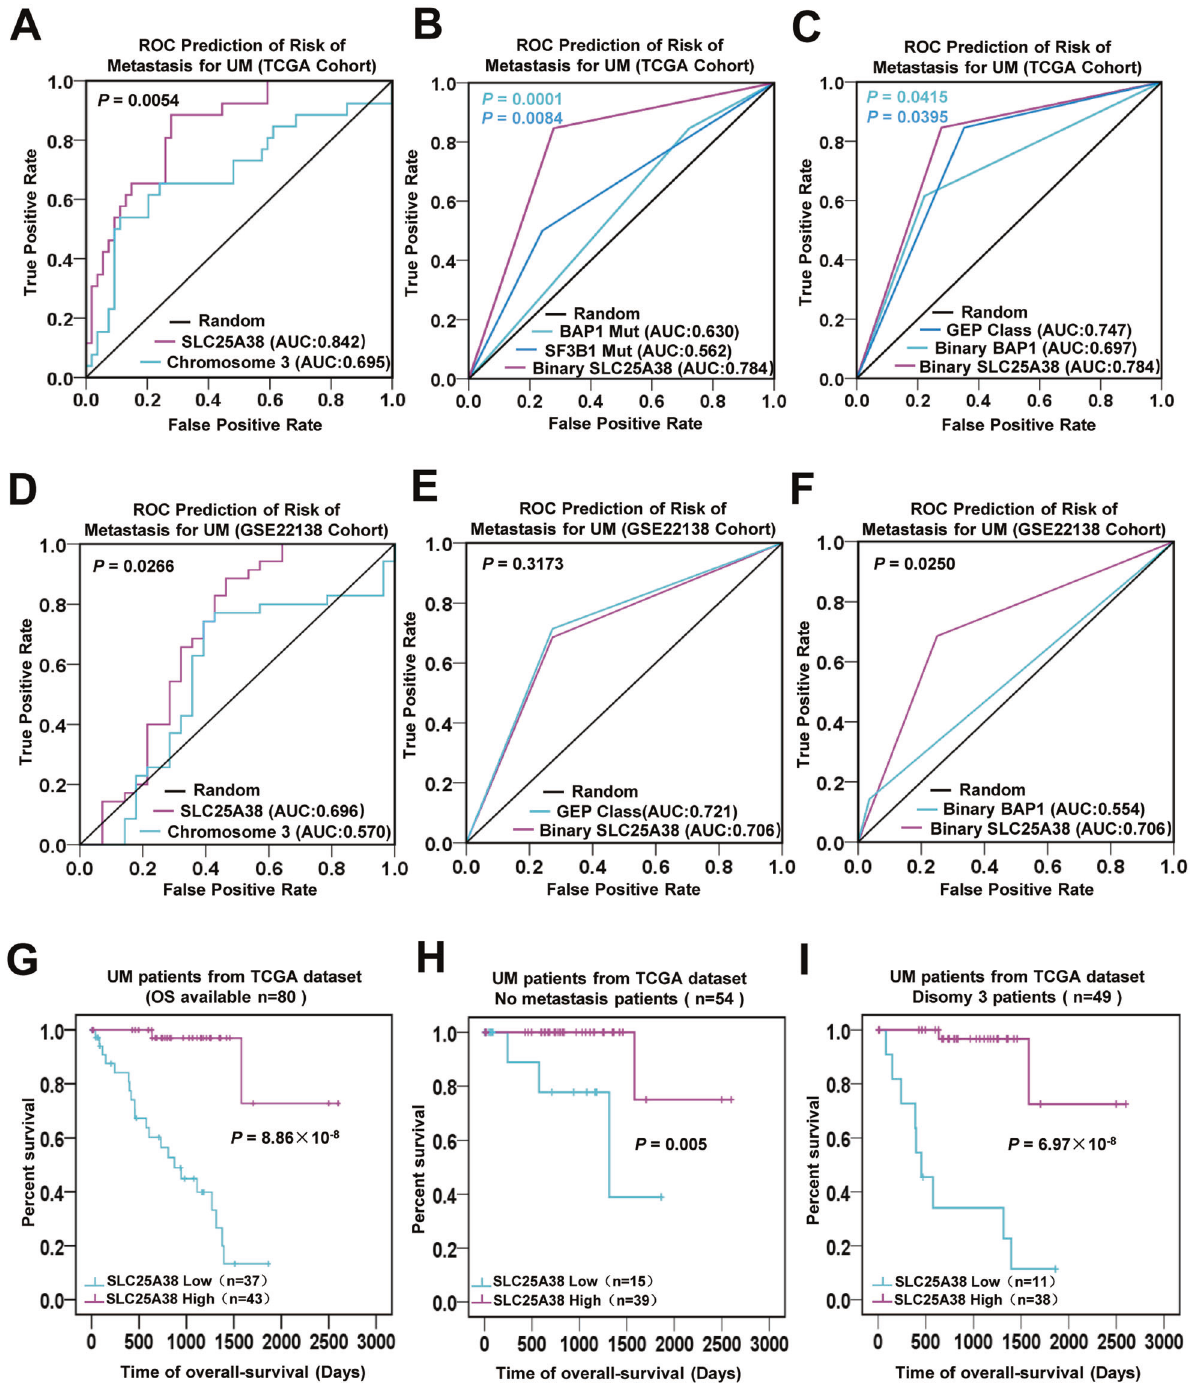
Fig. 2 Model accuracy and survival analyses in UM. A – F Receiver Operator Curves based on different feature sets in TCGA cohort ( A – C ) and GSE22138 cohort ( D – F ). The predictive accuracy of SLC25A38 expression for risk of metastasis was superior to that of other biomarkers. The P - value in light blue in B indicates Binary SLC25A38 vs BAP1 Mut, and the P -value in dark blue in B indicates Binary SLC25A38 vs SF3B1 Mut. The P -value in light blue in C indicates Binary SLC25A38 vs Binary BAP1, and the P -value in dark blue in C indicates Binary SLC25A38 vs GEP Class. G – I Survival curves based on SLC25A38 expression level. Low expression of SLC25A38 predicted poor clinical outcomes not only in all patients but also in patients without metastasis or patients with disomy 3 in TCGA UM cohort. AUC Area Under